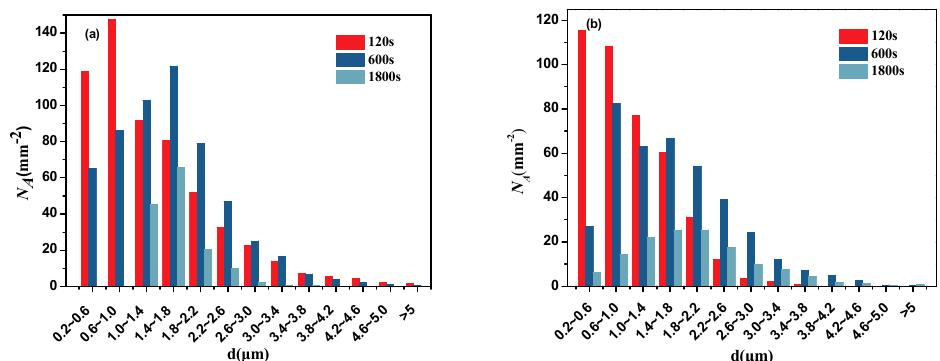
Figure 3. Two-dimensional size distribution of inclusions as a function of holding time. ( a ) Al deoxidation, ( b ) Al-Mg complex deoxidation.